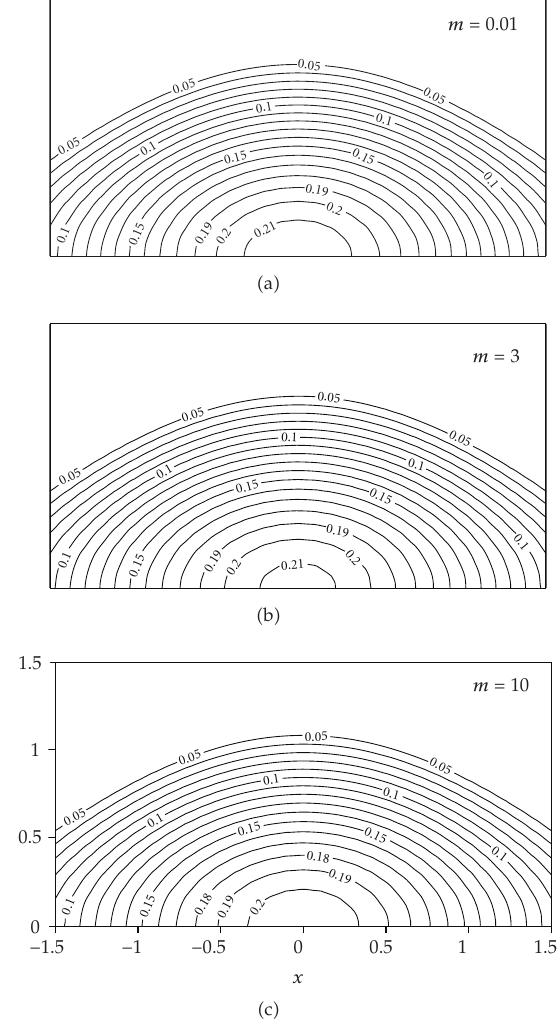
Figure 16: Magnetic-force lines for di ff erent values of m